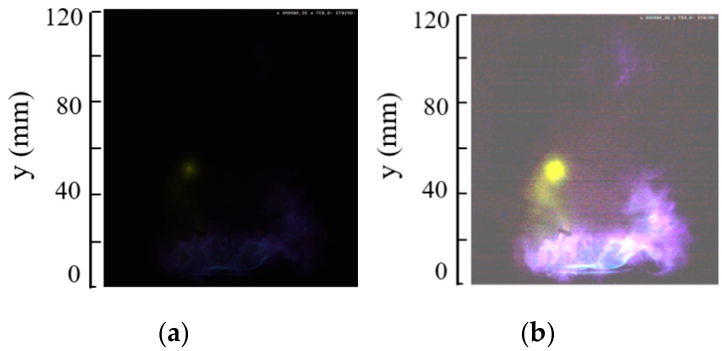
Figure 4. Comparison between ( a ) the original flame image and ( b ) the enhanced image through the spatial filter method.